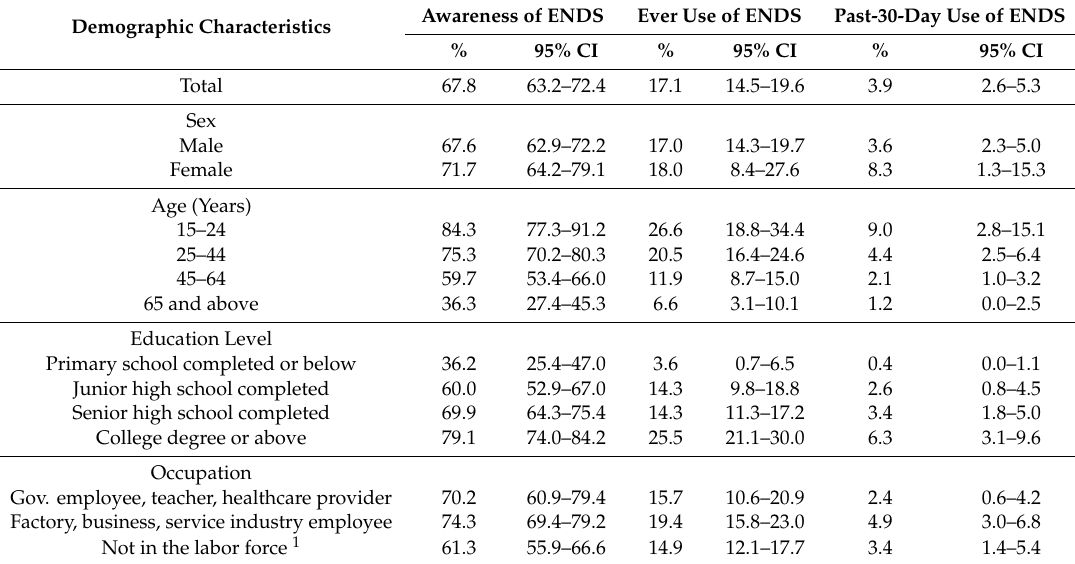
Table 3. Overall awareness, ever use, and past-30-day use of ENDS among adult smokers in five Chinese cities in 2018, N =